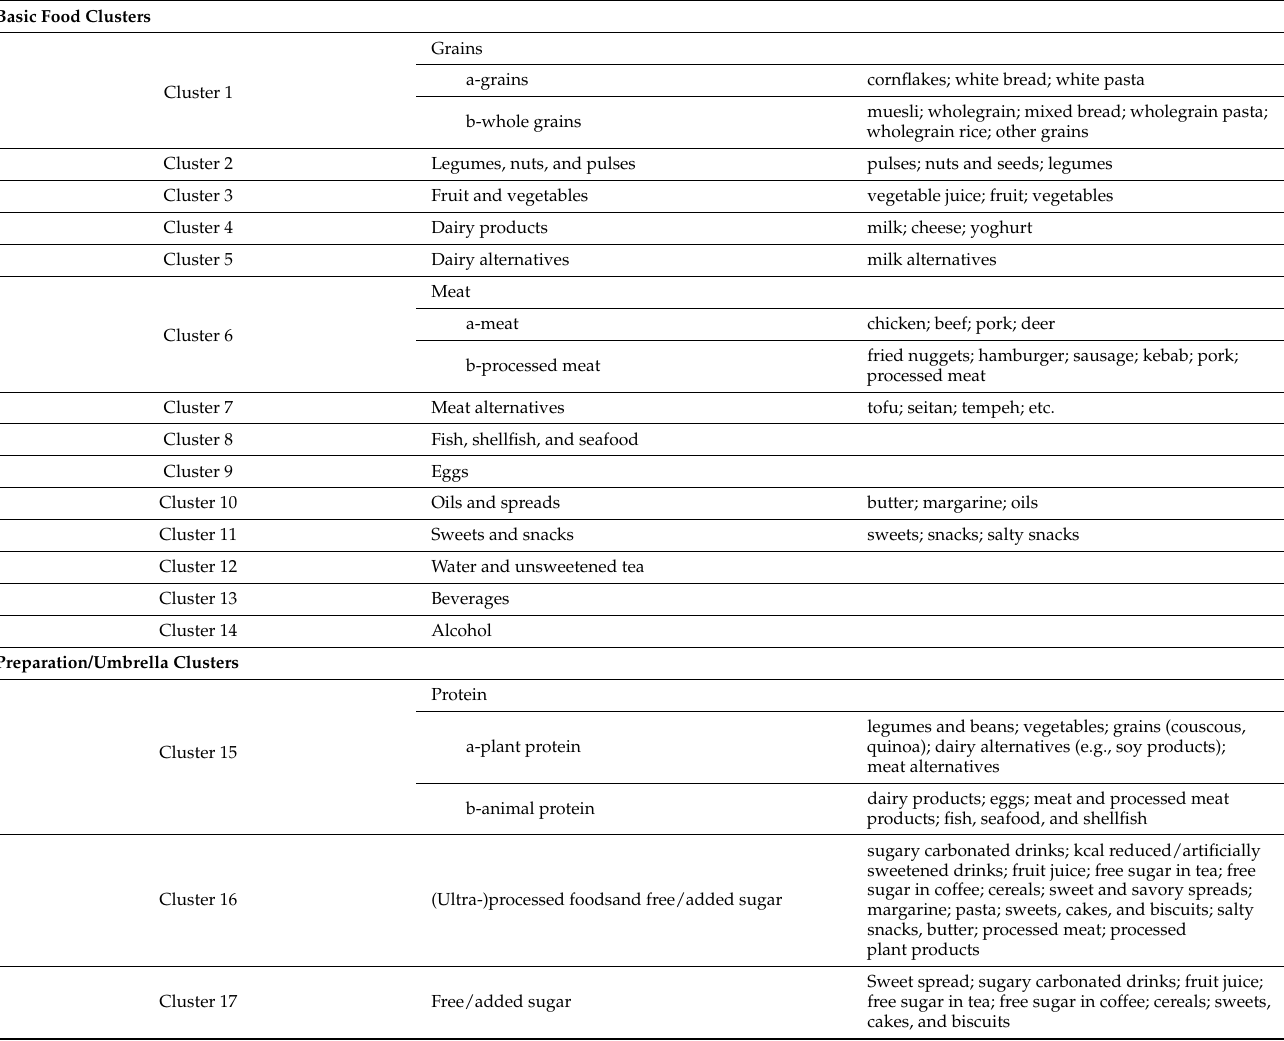
Table 1. Modeling of the Food Clusters: 14 Basic Nutrition and Consumption Clusters with 3 Umbrella-Preparation